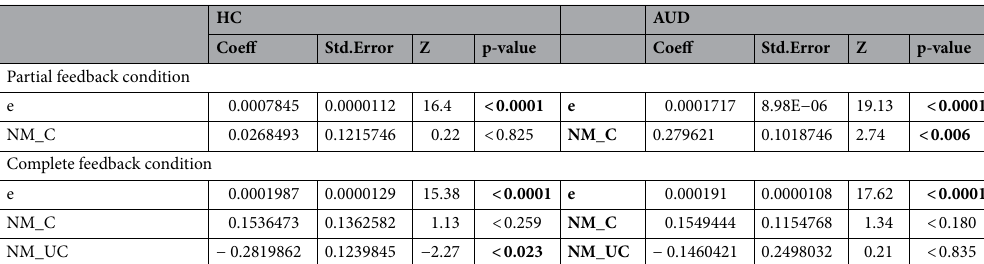
Table 4. Choice behaviour at the WoF task: Model 2. The table reports the results of a model of choice integrating the effects of previous experiences of near miss outcome associated with the chosen (NM_C) and unchosen (NM_UC) gambles, in addition to the maximization of expected value (e). Bold values denote statistical significance at the p < 0.05 level.